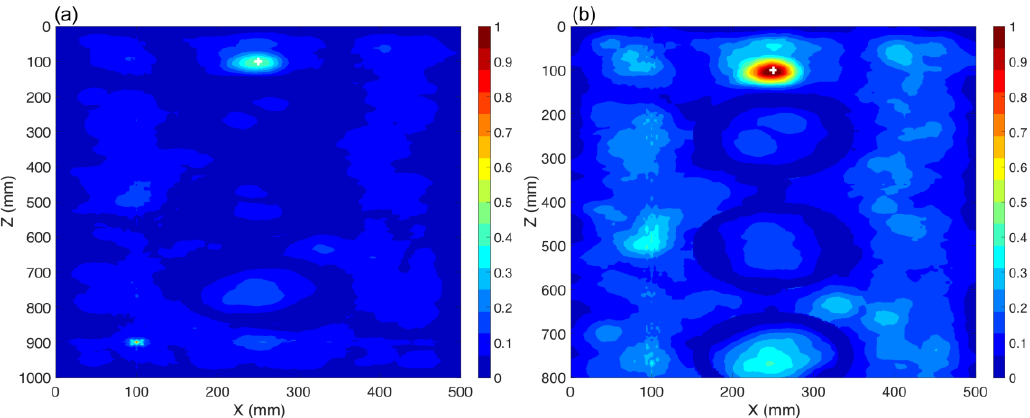
Figure 4. Normalized distribution of the maximum electric field power over the time inside the transformer tank (CS #2). The ground truth location of the PD source (PD1) is shown by the “+” marker. Only one sensor (S1) is used.